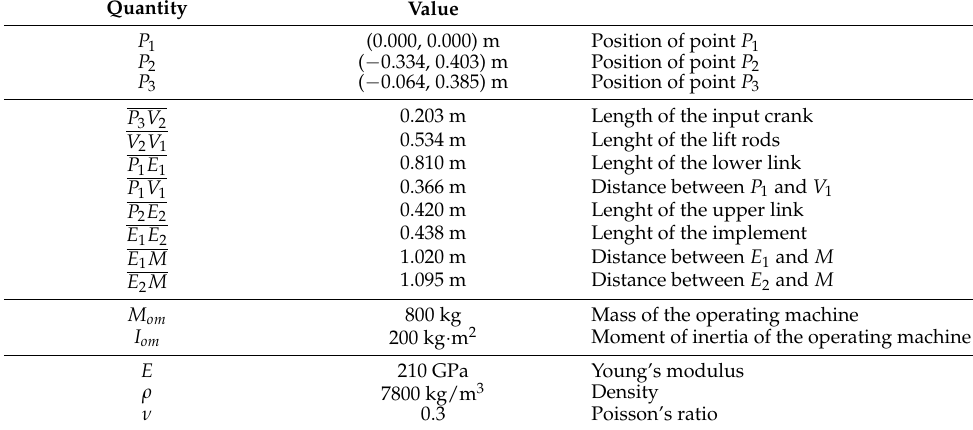
Table 1. Principal dimensions of the three-points linkage and inertial properties of the operating